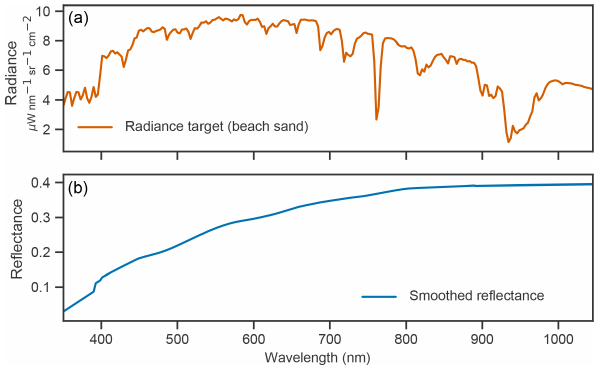
Figure 6. PRISM radiance spectrum (a) and the resulting smoothed reflectance (b) spectrum for the beach sand target used in the vicar- ious calibration